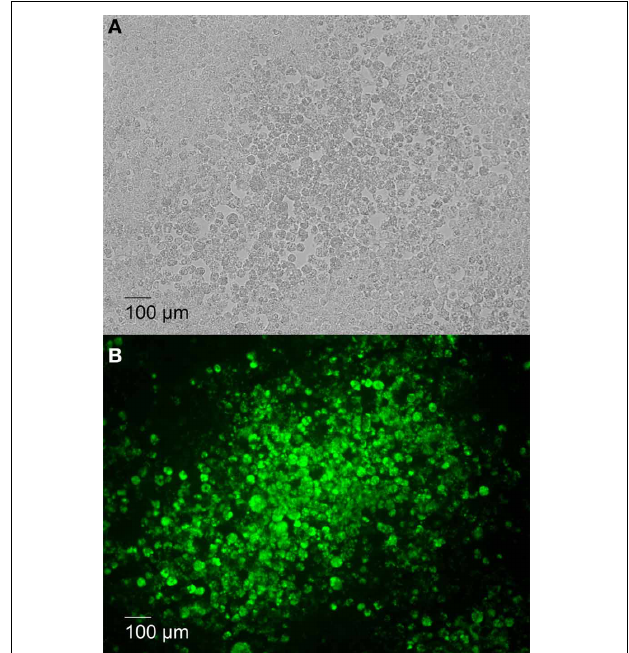
FIGURE 2 | Plaque formation corresponds with increased intracellular Brucella replication. J774.A1 macrophages were infected with 16M (cid:2) manBA atanMOIof0.1.AnagaroseoverlayandDMEMwereaddedat 1h p.i. and incubated an additional 4 days. Following fixation in 3.7% (w/v) formaldehyde, rough Brucella were visualized via IFA and IX70 microscopy under phase contrast field (A) and fluorescent field (B) (showing Brucella replication in green) microscopy. Scale bar, 100 μ